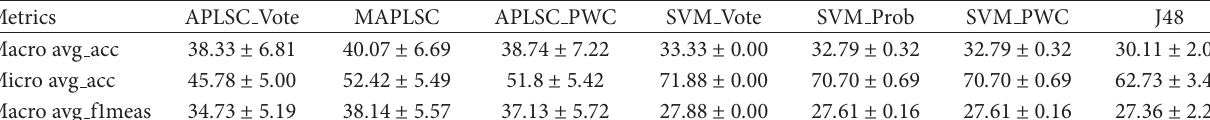
Table 4: Comparative results on syndrome classification.